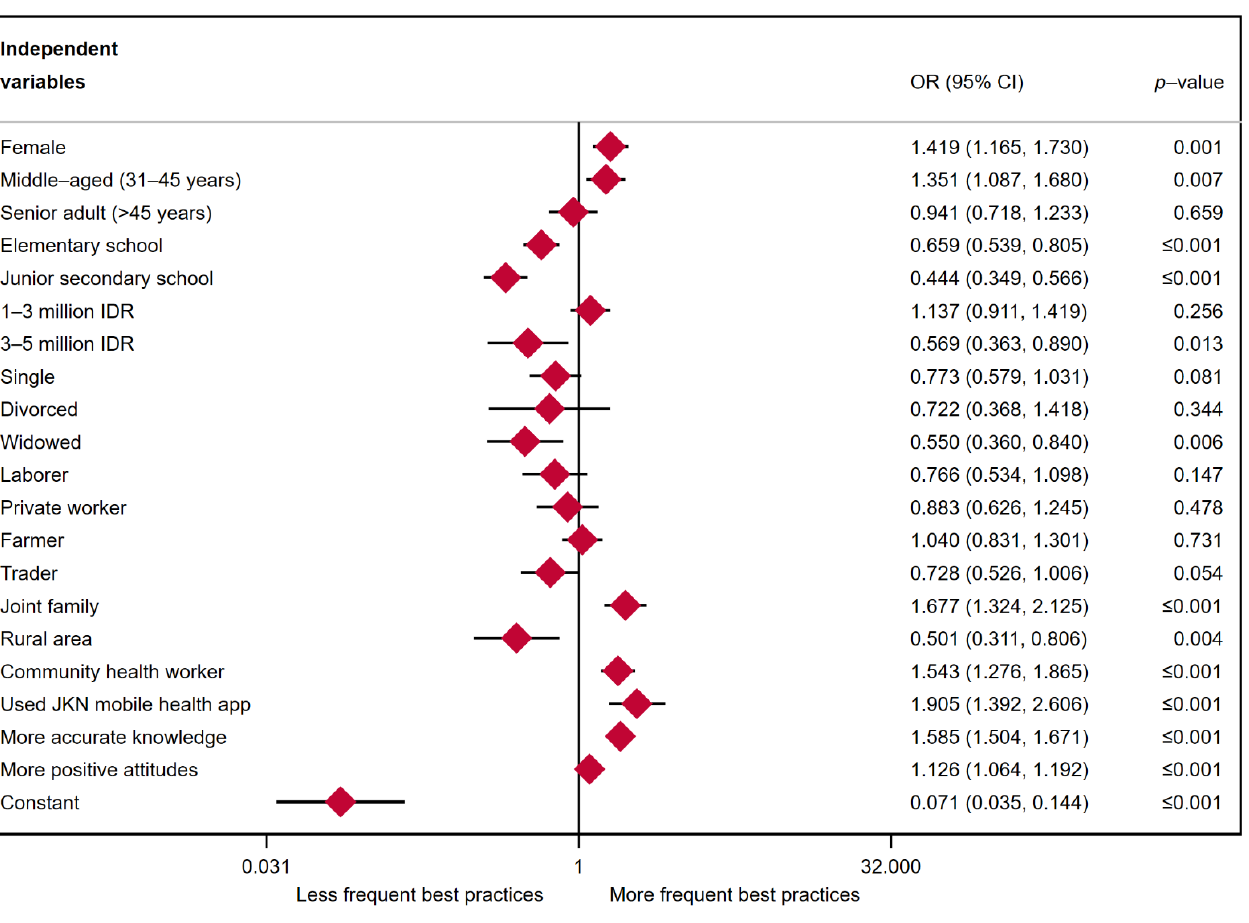
Figure 3. Multiple logistic regression results: practices toward COVID-19 prevention.